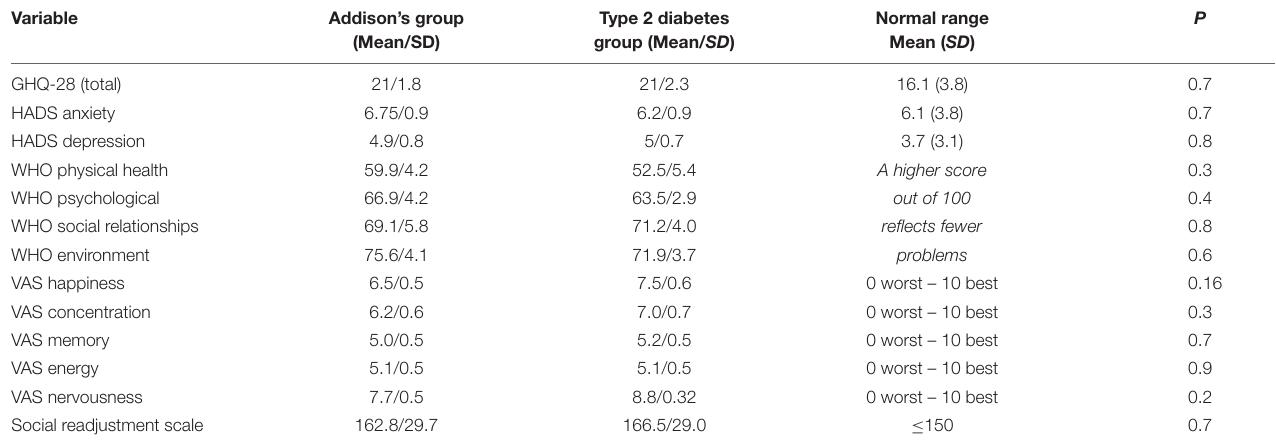
TABLE 4 | Comparison of the Addison’s patient group and the type 2 diabetes patient group. Variable Addison’s group